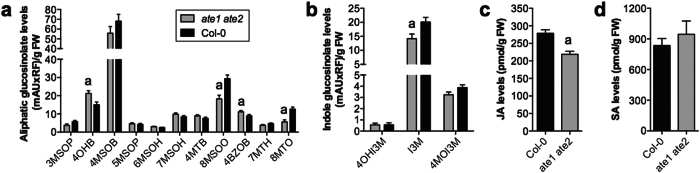
Glucosinolate and JA levels are reduced in ate1 ate2 mutant seedlings.(a) Levels of different aliphatic glucosinolates. (b) Levels of different indole glucosinolates. mAU: milli Absorption Units; RF: Response Factor which takes into account that different glucosinolates absorb UV with different efficiencies; FW: fresh weight. Error bars represent SEM of 9 independent biological replicates. (c) JA levels in wild-type (Col-0) and ate1 ate2 seedlings. Error bars correspond to SEM of seven independent biological replicates. The results of Student’s t-tests are shown with ‘a’ indicating a P-value < 0.05. (d) SA levels in wild-type (Col-0) and ate1 ate2 seedlings. Error bars correspond to SEM of three independent biological replicates.